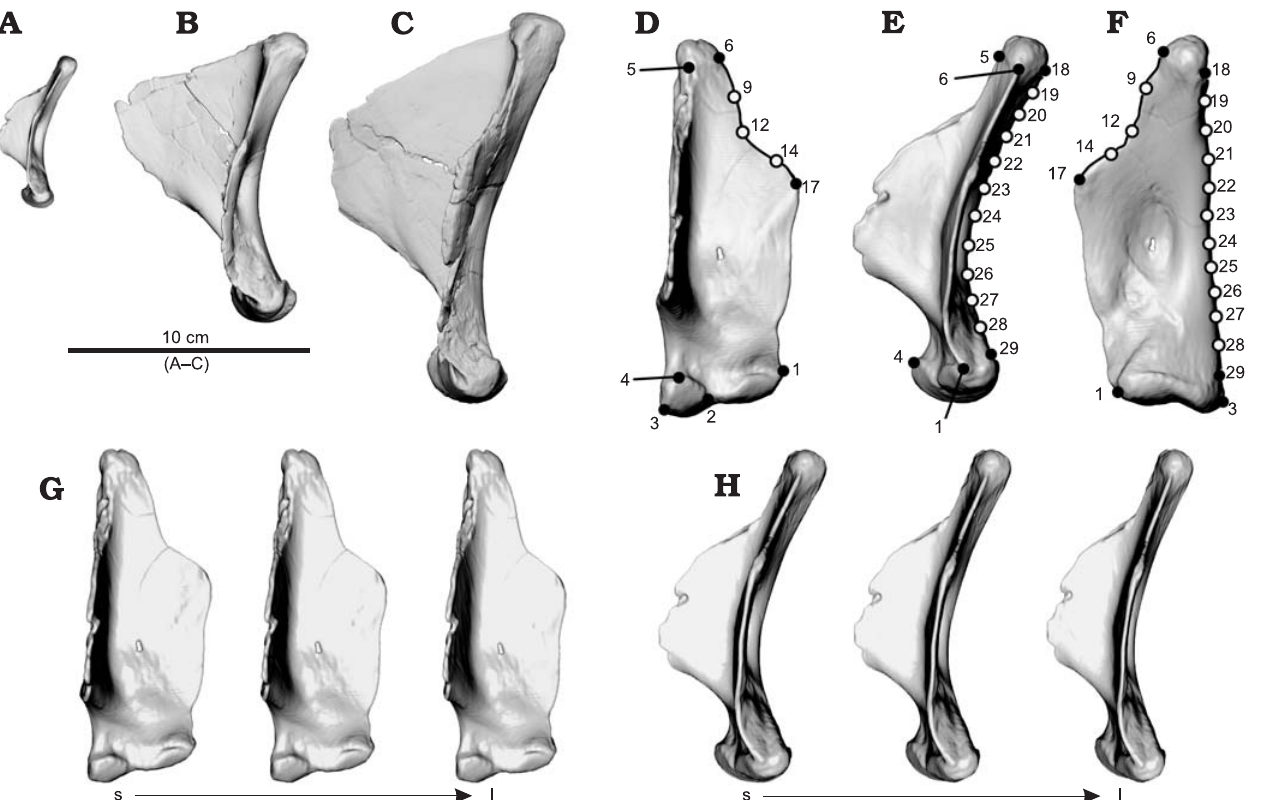
Fig. 8. Representative right quadrates (rendered CT images) of Majungasaurus crenatissimus (Depéret, 1896) Lavocat, 1955 from the Maastrichtian (Upper Cretaceous) Maevarano Formation, northwestern Madagascar in left lateral view. A . UA 10000. B . UA 9944. C . FMNH PR 3369. D – F . Landmark positions in anterior ( D ), left lateral ( E ), and posterior ( F ) views. G , H . Warped meshes, rostral ( G ) and lateral ( H ) views, showing idealized transforma- tion of smallest (s) to largest (l) elements in the size range